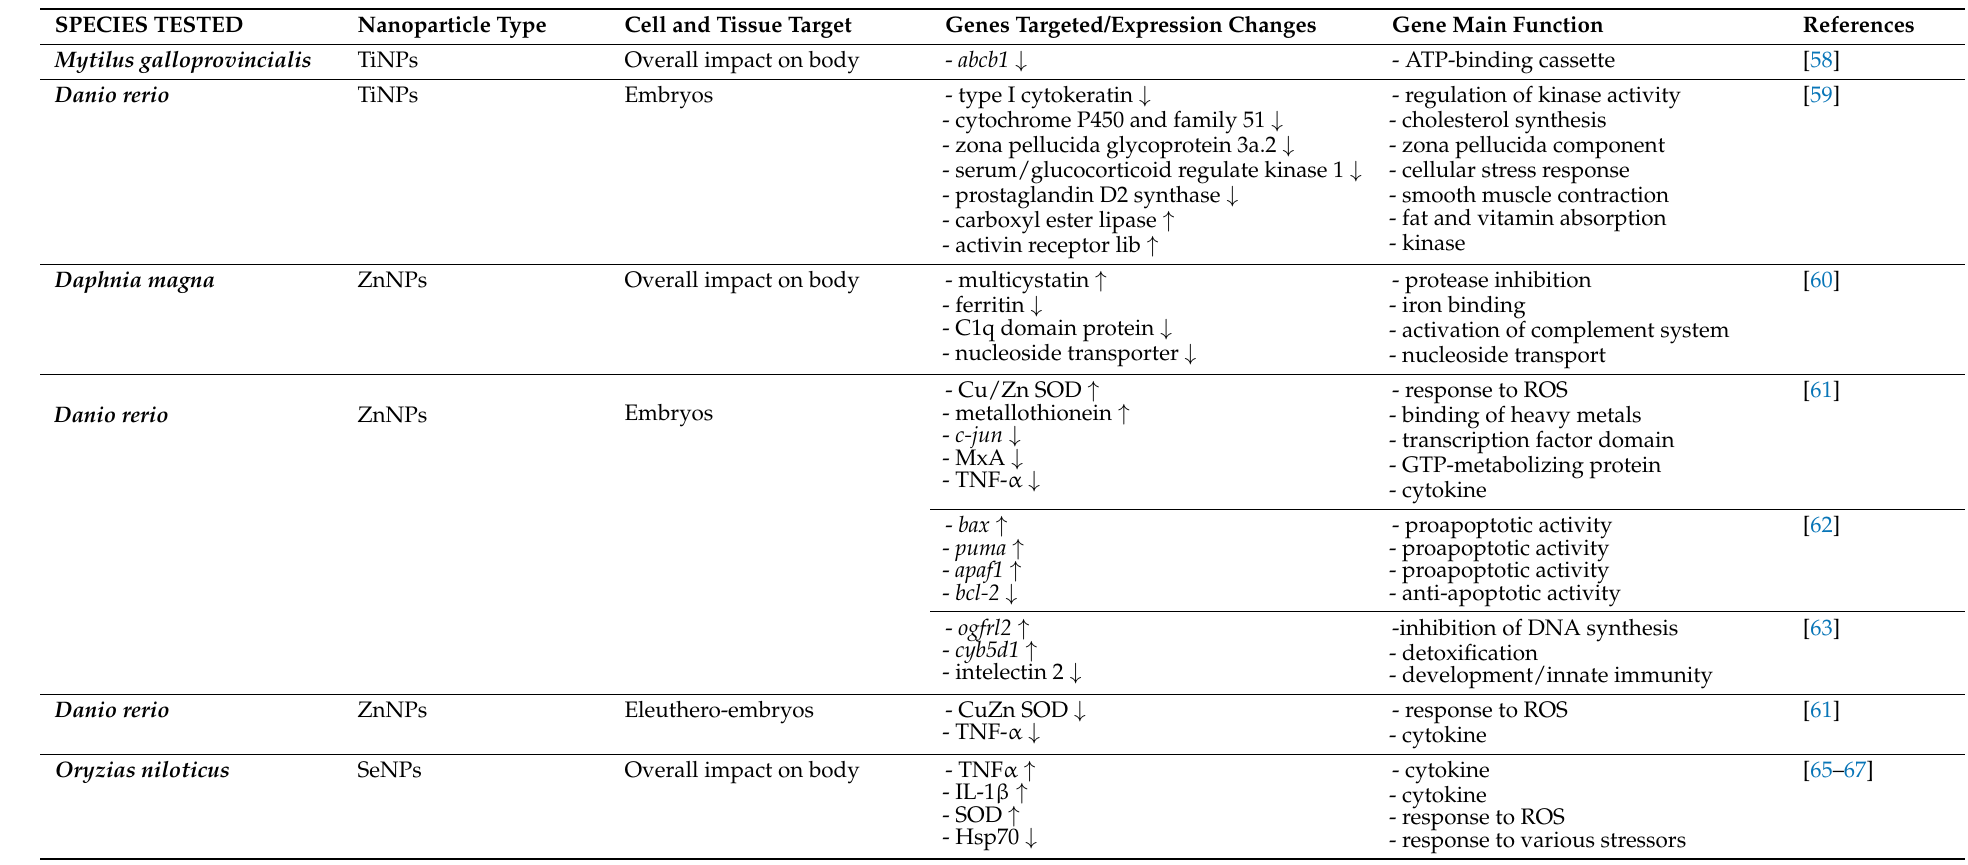
Table 3. Effects of other metal nanoparticles on the expression of genes of water